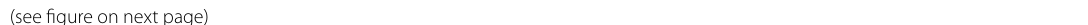
Fig. 1 A 34-year-old female presented with right breast lump. Pre-therapy : a Focal spiculated mass at the central portion of the right breast. Associate ipsilateral dermal thickening and interstitial edema with few pathologically enlarged right axillary lymph nodes (not seen in the figure). The mass showed delayed peak of contrast uptake at 260 s with corresponding maximum relative enhancement at 208% and delayed washout curve pattern Ib. b ADC map showed intermediate signal of the tumor and a low ADC value of 0.861 10 − 3 mm 2 /s. c MRS was positive for choline × (choline peak 0.9 mmol/l). Histopathology : Invasive lobular carcinoma pleomorphic type grade II associated with lobular carcinoma in situ. = Immunohistopathology : Negative for ER and PR , positive for HER 2 NEU (class 3 ) , Ki 67 15%. Treatment decision : Neo-adjuvant chemotherapy and + breast conservative surgery. Post-therapy : d Dramatic reduction in the size of the right breast mass. The skin thickening of 4 mm is still noted. Faint contrast uptake was noted at the confine of the right breast mass, arrow (note, a clip is seen inserted within the vicinity of the mass), with marked reduction in the percentage of signal intensity to be 23%. e DWI examination showed increased ADC value of 1.255 10 − 3 mm 2 /s. f MRS showed × favorable post-chemotherapeutic response in the form of reduced choline peak to reach 0.2 mmol/l. Pathology report of the surgical specimen : Tiny remnants of intra duct carcinoma surrounded by hyalinosis. Examination of sentinel lymph nodes showed positive metastatic deposits (1/1). All of the dissected axillary lymph nodes were negative for metastatic deposits (0/11). The surgical margins were free. Comments : Near